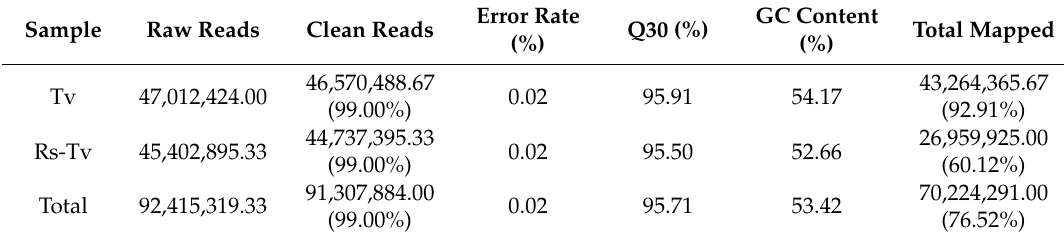
Table 2. Results of transcriptome sequencing.